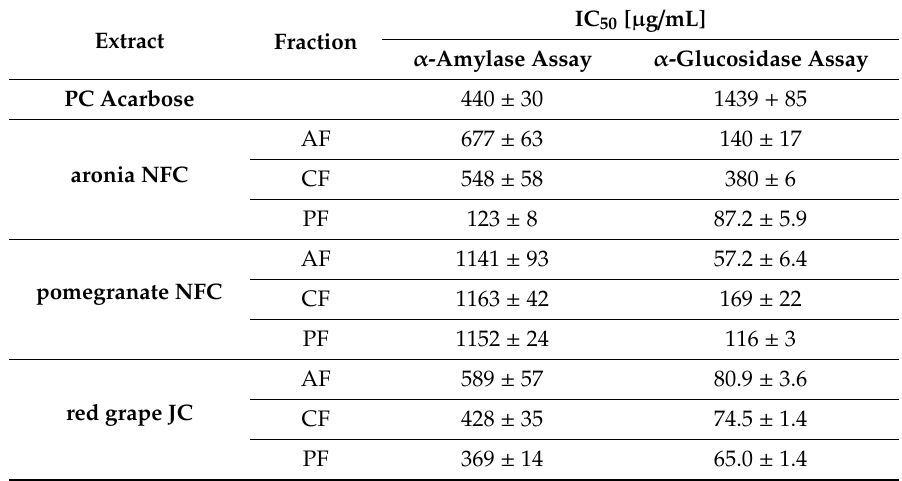
Table 2. Inhibitory activities (IC 50 values) of the three fractions (AF, CF, and PF) of the different juice extracts. Results are presented as means ± SD ( n = 3).